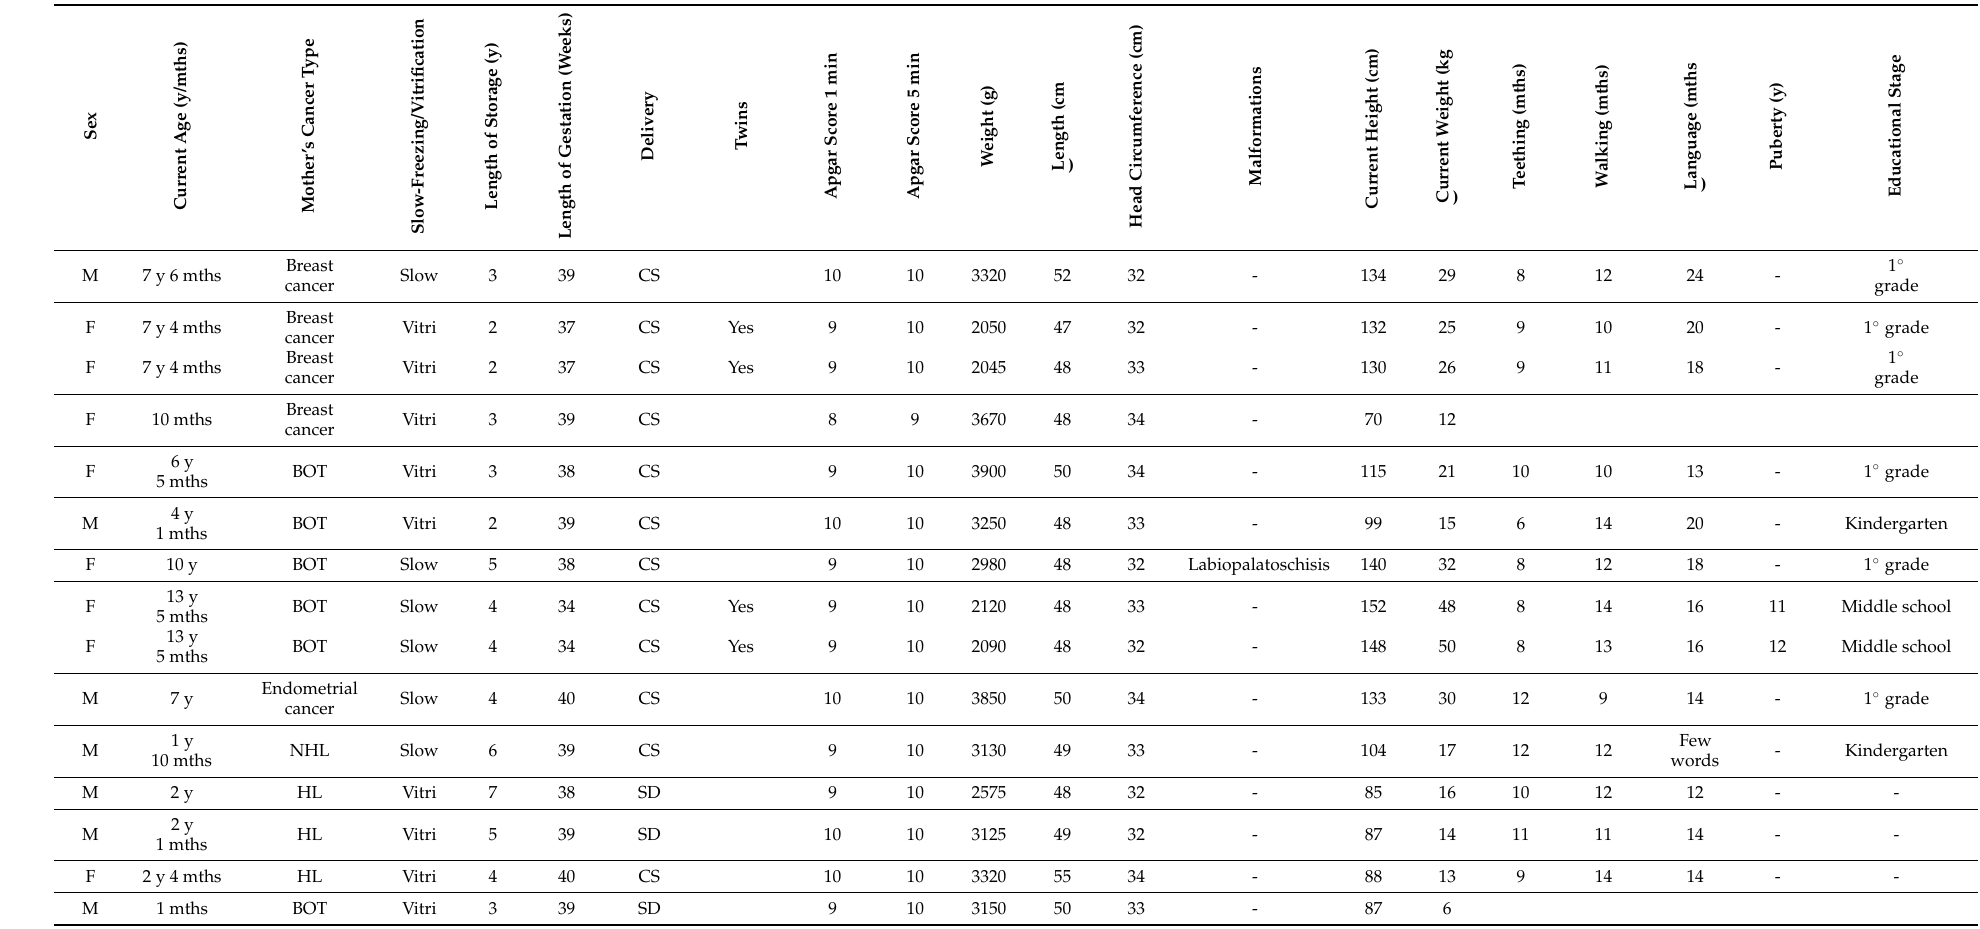
Table 5. Long-term follow-up of children conceived with oocytes cryopreserved in cancer